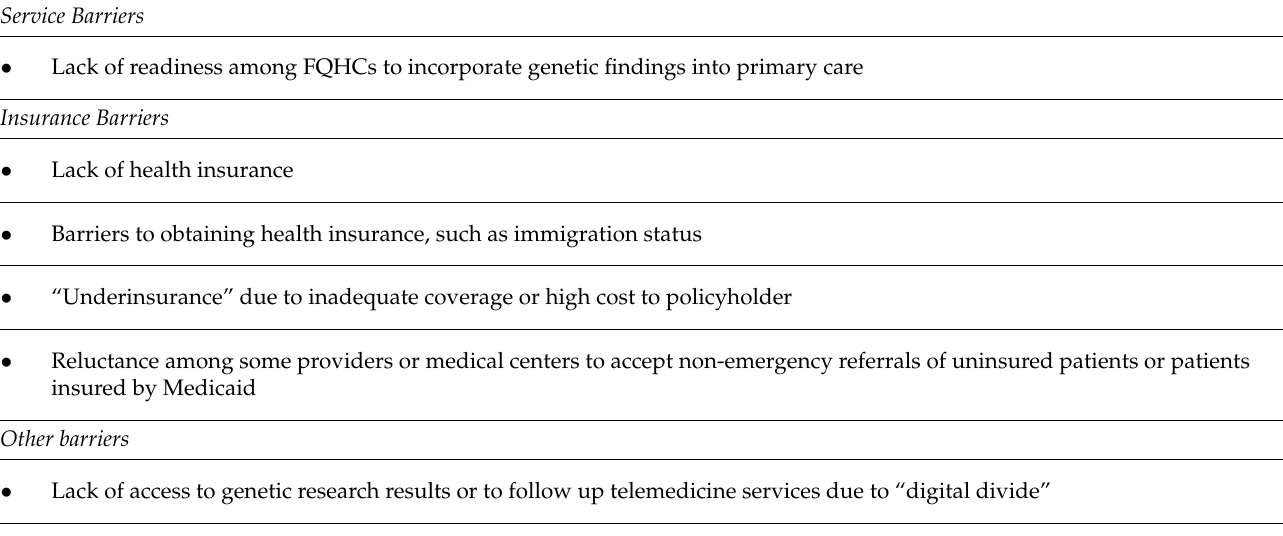
Table 1. Obstacles to follow up medical services upon return of genetic